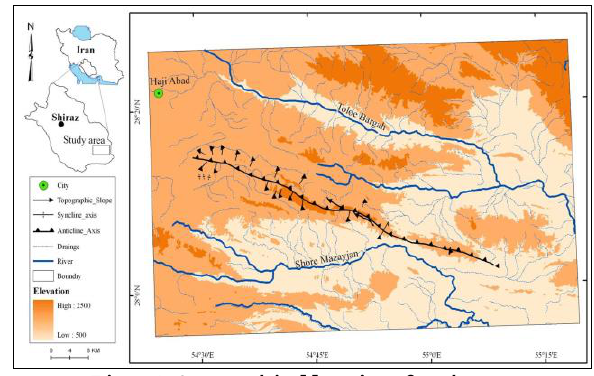
Figure1. Geographical location of study area